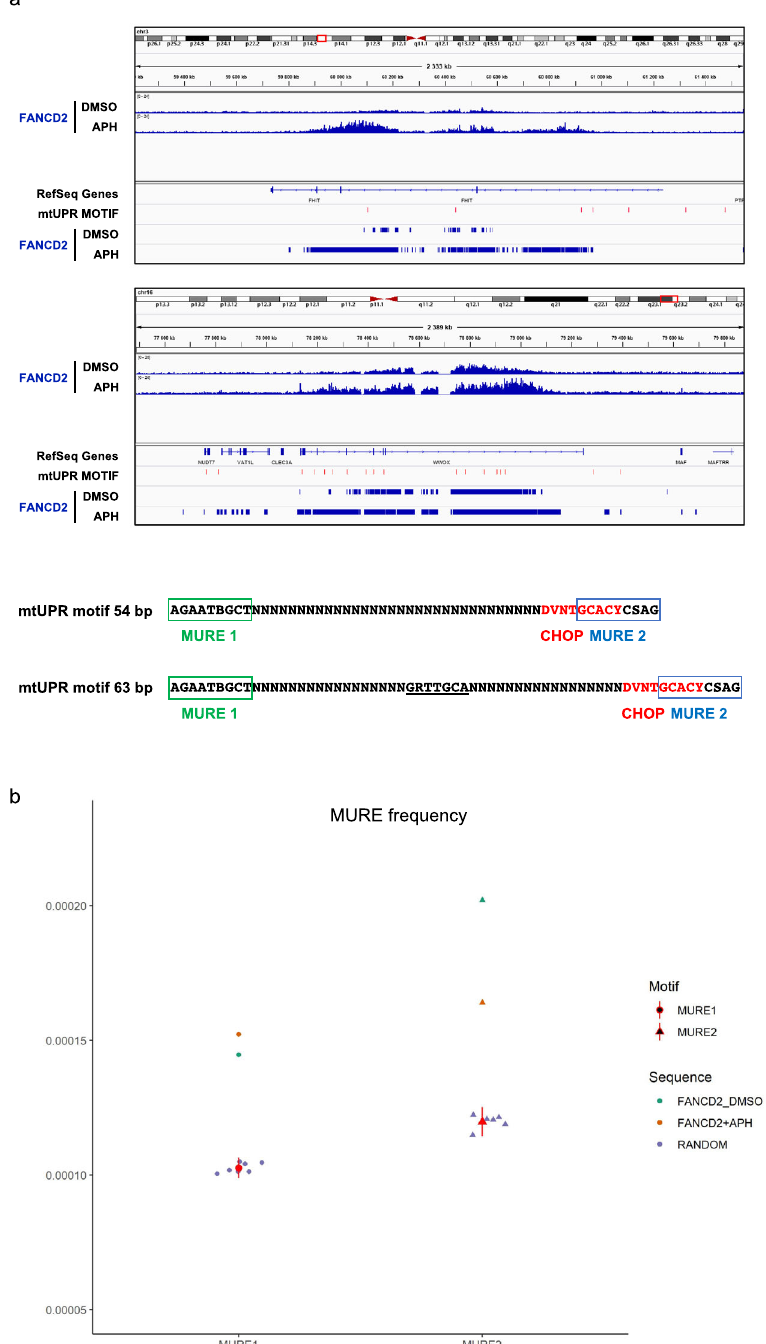
Fig. 3 Genome-wide analysis of FANCD2 targets identi fi es an enrichment for mitochondrial UPR-response elements at FANCD2-binding sites. a IGV visualization of FANCD2 enrichment along the CFS genes FHIT and WWOX in the presence or absence of APH and the relative position of mitochondrial UPR (mtUPR) motifs (red tags) and FANCD2 peaks. FANCD2 ChIP seq data were scanned with regulatory sequence analysis tools (RSAT)-matrix- scan 89,90 to identify instances of MURE1, MURE2 (mitochondrial UPR response elements) and CHOP motifs as they were de fi ned by Aldridge et al. (2007) and Munch and Harper (2016) 46,47 . mtUPR motifs represent sequences of 54 or 63 bp with MURE1 – CHOP – MURE2 consensus elements as indicated. The conserved CHOP consensus between MURE1 and MURE2 elements as reported by Aldridge et al. is underlined. Notice that a 10 bp consensus sequence for CHOP described in Munch and Harper is partially overlapping the MURE2 element. b Frequency of MURE1 and MURE2 elements at FANCD2-binding sites relative to a random control. The matches scored for each motif were compared to those detected in n = 7 (MURE1) or n = 6 (MURE2) independent sets of random sequences of identical length from human genome GRCh37-hg19. p values of the probability to obtain a similar score were calculated with the chi- square test. **** p = 5.84e − 47 (MURE1), **** p = 1.91e − 174 (MURE2), and **** p = 1.85e − 69 (MURE1), **** p = 9.30e − 70 (MURE2) for FANCD2 in mock (DMSO) and APH-treated conditions,